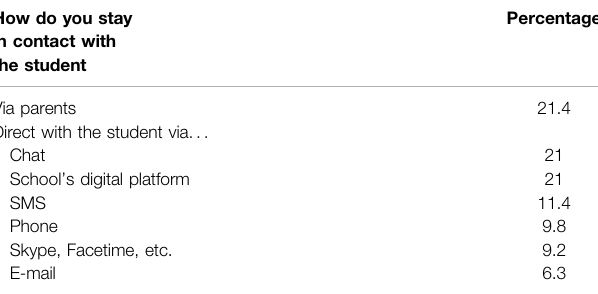
TABLE 4 | How teachers stayed in contact with the student.